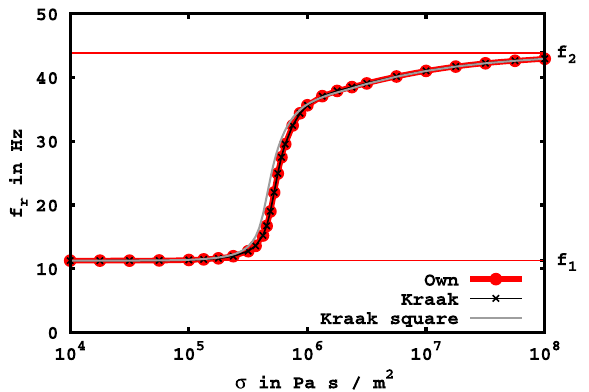
Figure 5. Shift of the resonance frequency f r depending on the fl ow resistivity r , lines for asymptotes at f